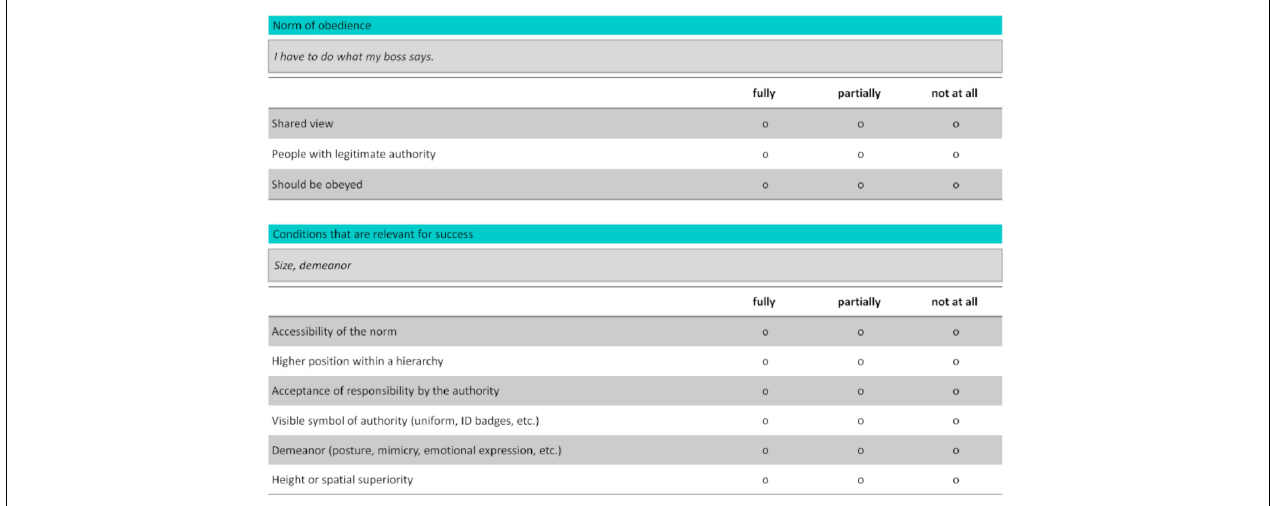
content items and asked the same open-ended questions but were based on different